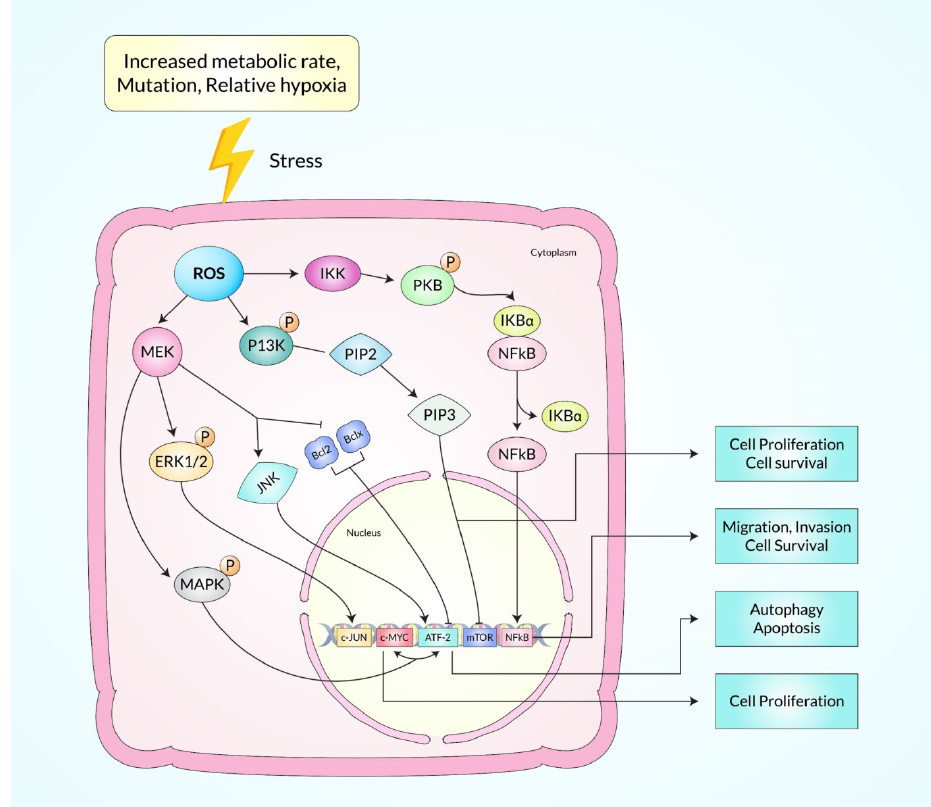
Figure 4. Diagrammatic illustration of oncogenic transformation and immortalized conditions by the presence of chemotherapeutic agents that augment ROS production. Tumor suppressor gene p53 is decreased in cancer cells which upregulates antioxi- dants genes such as MnSOD2, tumor protein P 53 -inducible nuclear protein 1 (TP 53 INP 1), GPX, TP 53 -induced glycolysis and apoptosis regulator (TIGAR), and SESN 1/2, the sestrins, which encode antioxidant modulators of PRDXs for which the ROS levels are produced more in cancer cells but endogenous antioxidants balance the ROS levels [8]. 6.2. Unbalanced Reactive Oxygen Species in Cancerous Cells by Quercetin QC is a nutritional supplement derived from daily food and plants such as green tea, vegetables, and fruits that belongs to the flavonoid’s family. The pharmacological and bi- oactive function of quercetin is highly absorbed in the conjugated form which is metabo- lized into QC-3-glucuronidated, methylated, and QC-3 ׳ -sulfated in the intestinal tract in the form of glycosides by glycosidase enzyme and excreted with urine in the kidney as shown in Figure 5 [67].